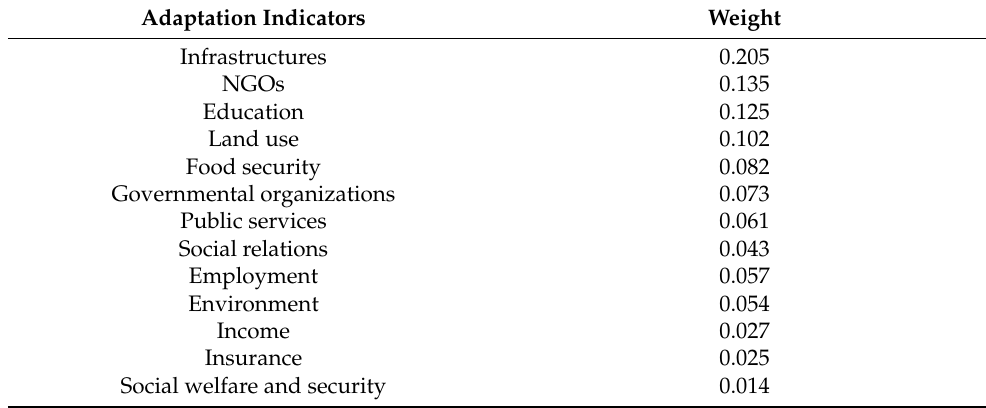
Table 5. The ultimate significance of the